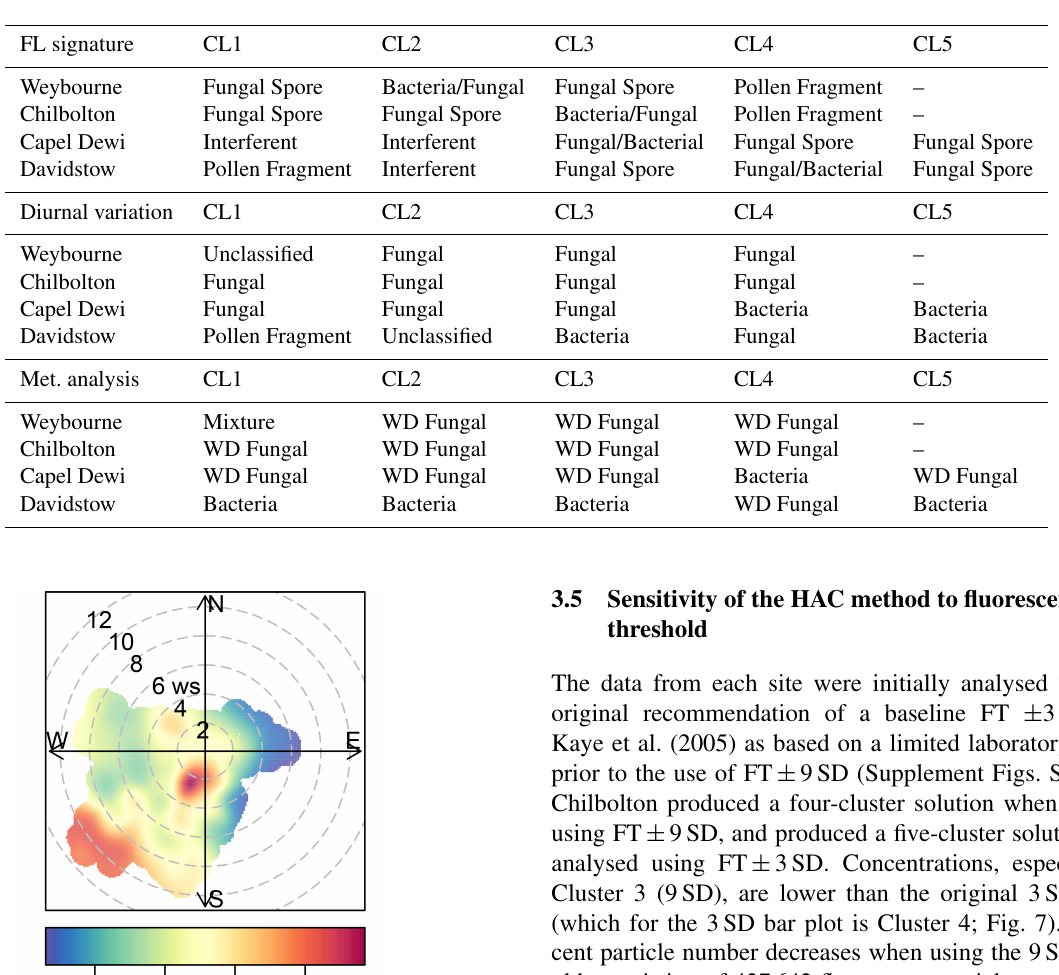
Table 4. Suspected particle class types at each site showing the inferred cluster types following fluorescence signal analysis, and the suggested particle types following the cluster diurnal time series, and meteorological data analysis (temperature and RH). (Note: Weybourne and Chilbolton comprise 4 clusters, hence unassigned Cluster 5). WD represents wet discharged.